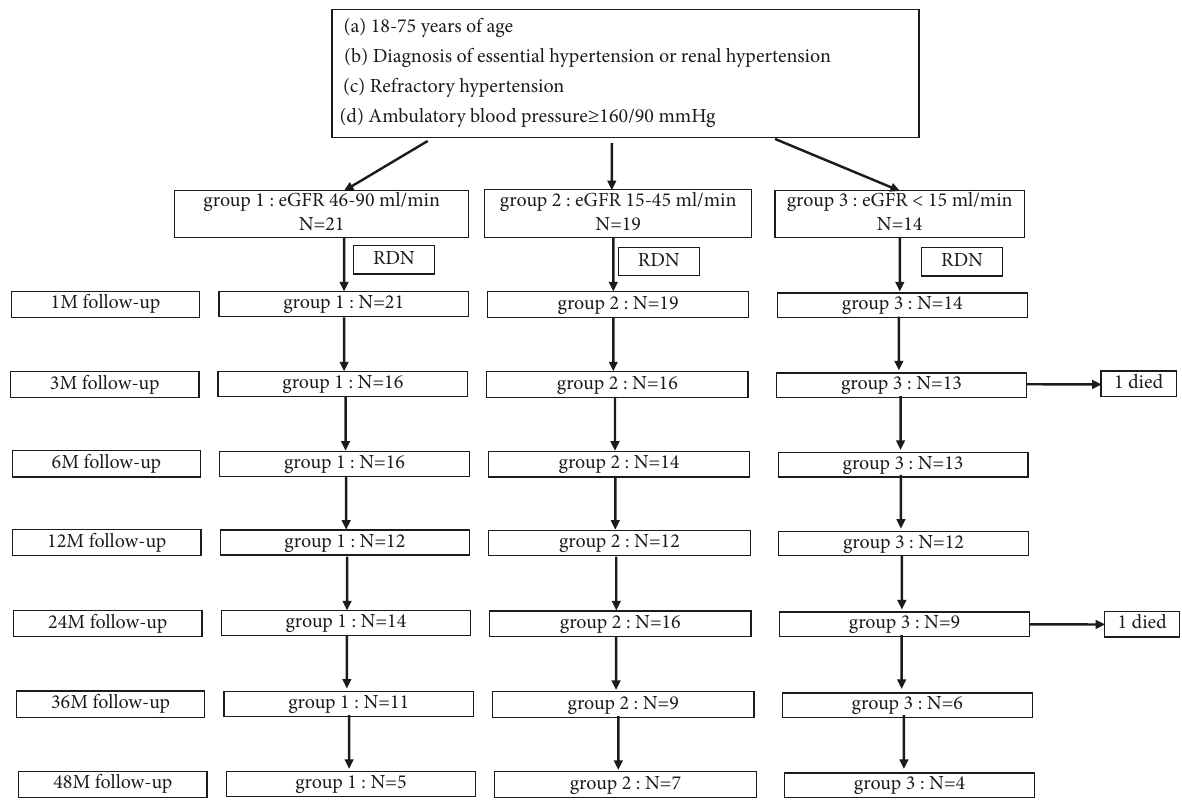
Figure 1: Flowchart of the